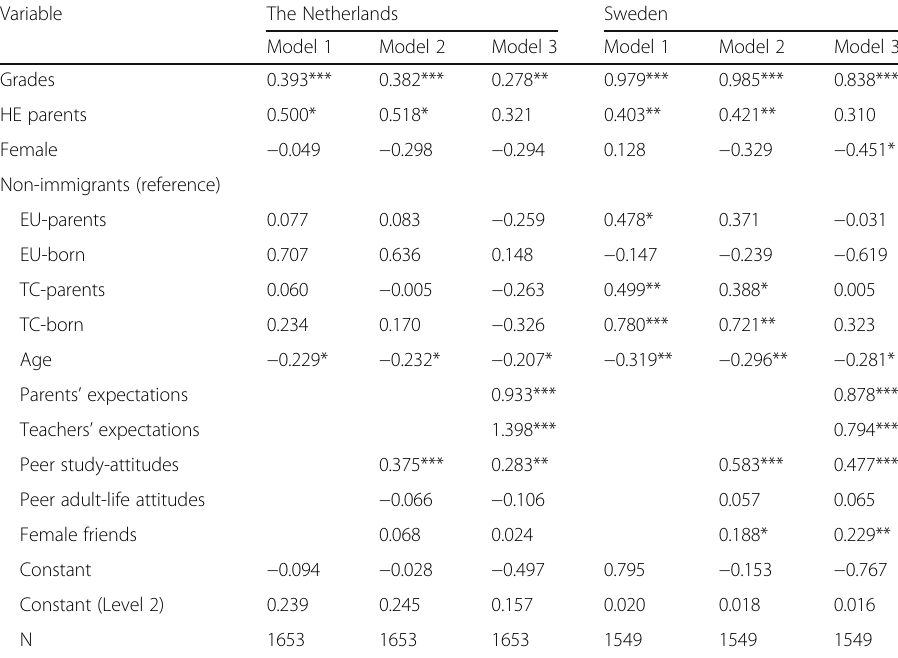
Table 5 Multi-level logit regressions. The effects of significant others on habituated university aspirations for Dutch & Swedish students Variable The Netherlands Sweden Model 1 Model 2 Model 3 Model 1 Model 2 Model 3